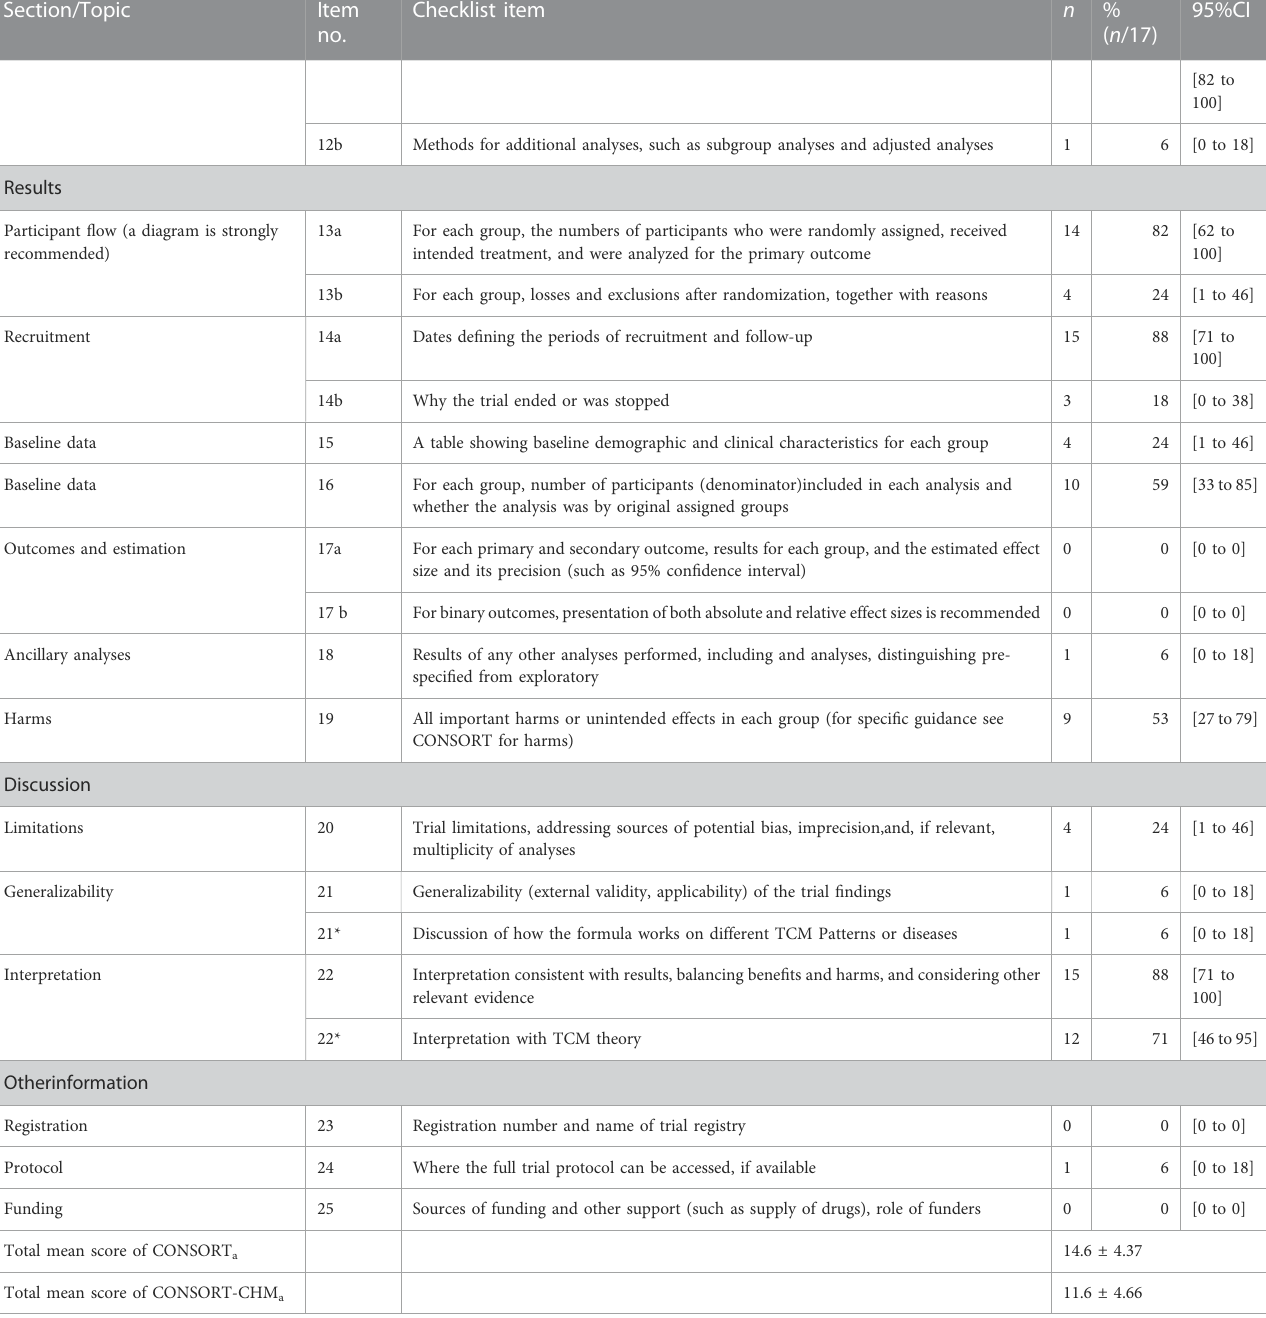
A table showing baseline demographic and clinical characteristics for each